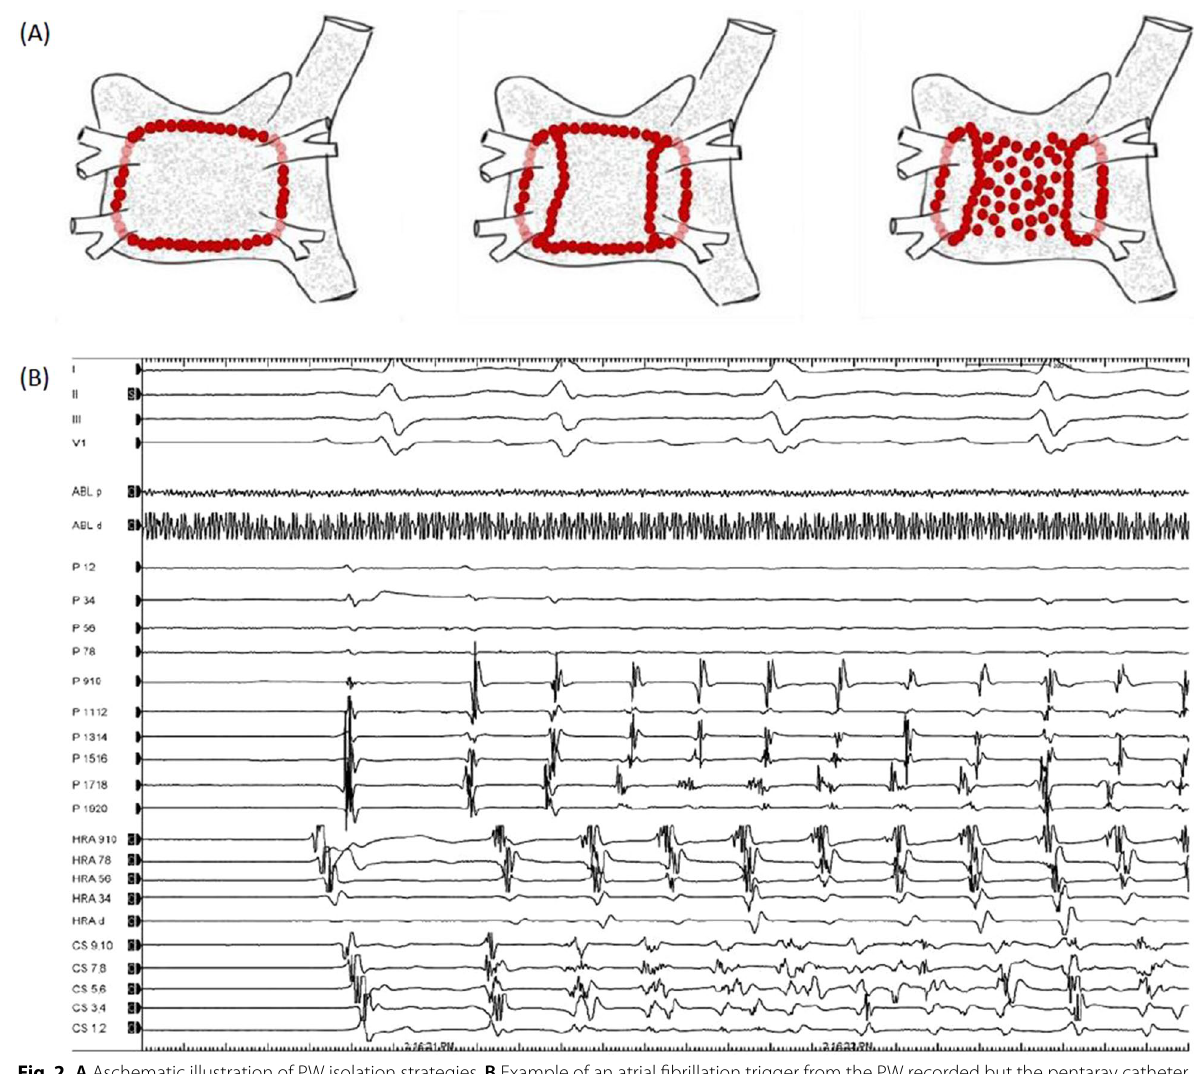
Fig. 2 A Aschematic illustration of PW isolation strategies. B Example of an atrial fibrillation trigger from the PW recorded but the pentaray catheter. ABL ablation, CS coronary sinus, d distal, HRA high right atrium, P pentaray, p